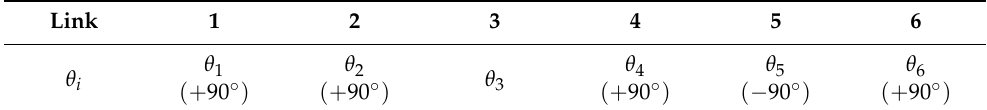
Table 2. D-H parameters of the scanning arm represented by joint